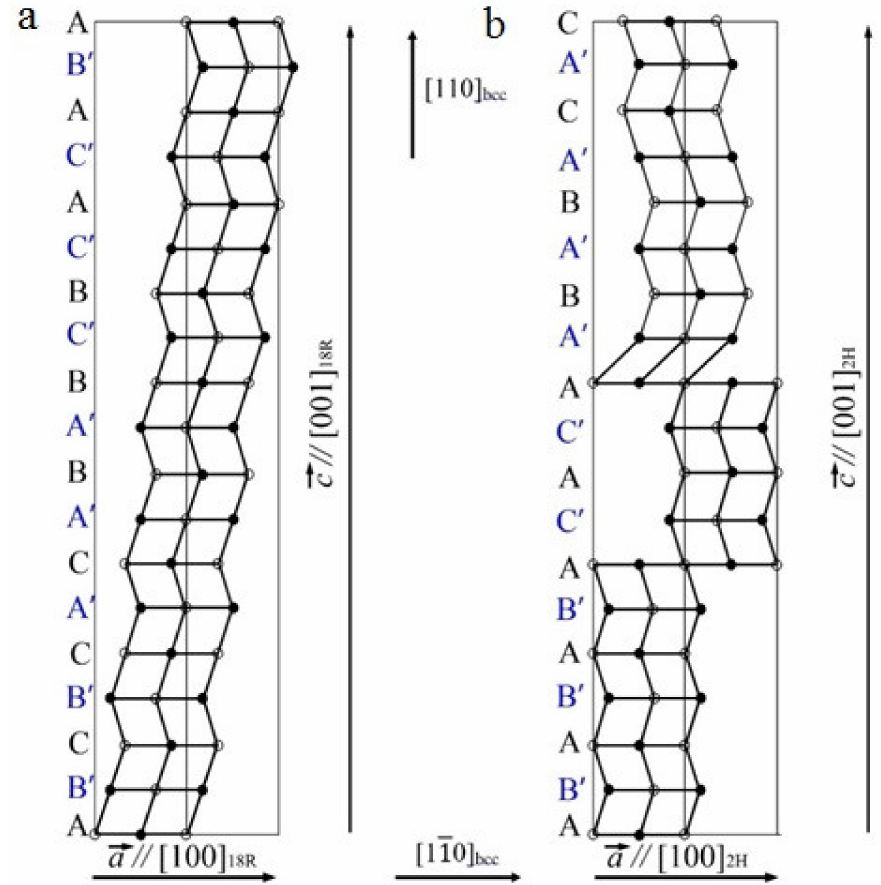
Figure 7. Schematics of crystal lattice rearrangement of type ( a ) D0 3 → 18R and ( b ) D0 3 → 2H martensite.